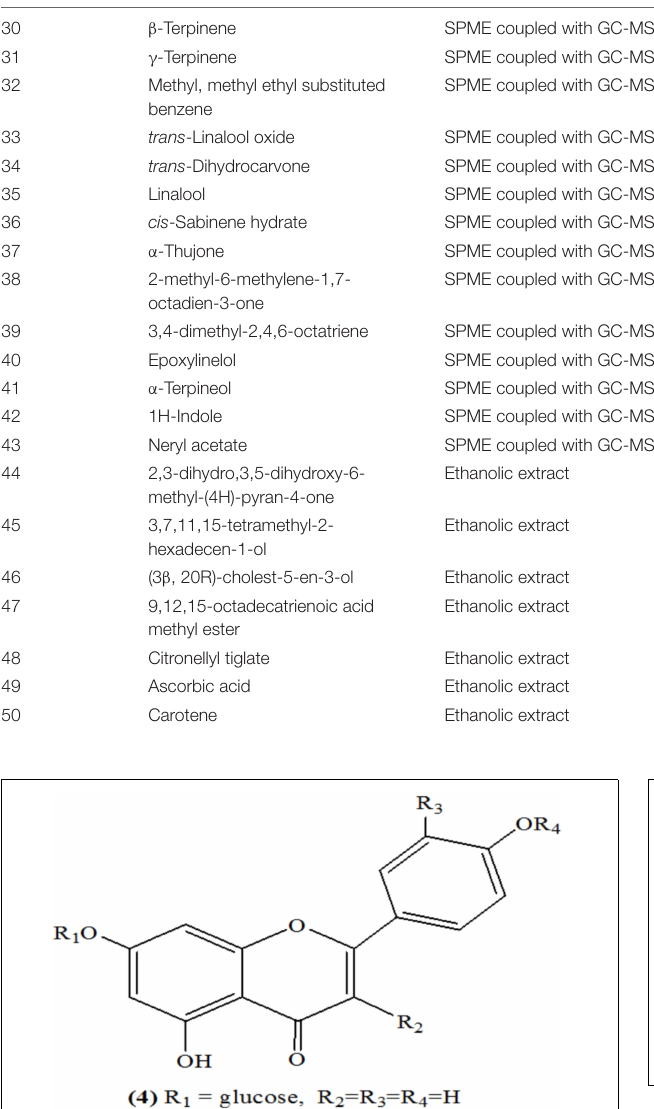
Seven saponins belonging to the oleanane – type triterpene were isolated from the aerial parts of Luffa acutangula ( Figure 4 ). Methanolic extract was repeatedly